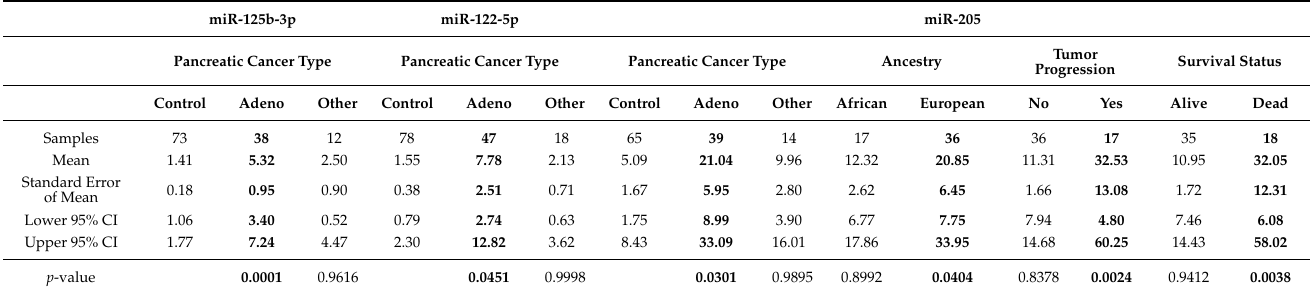
Table 4. Exosome-derived miR125b-3p, miR-122-5p and miR-205-5p with significantly differential expression in pancreatic cancer patients and healthy controls, divided according to cancer type, ancestry, tumor progression, and survival status.